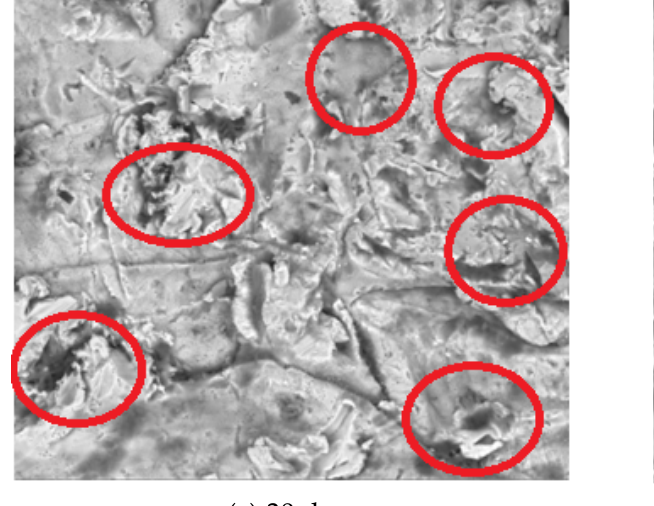
Figure 2. XRD plot for the 3D-printed CoCrMo metallic implant.